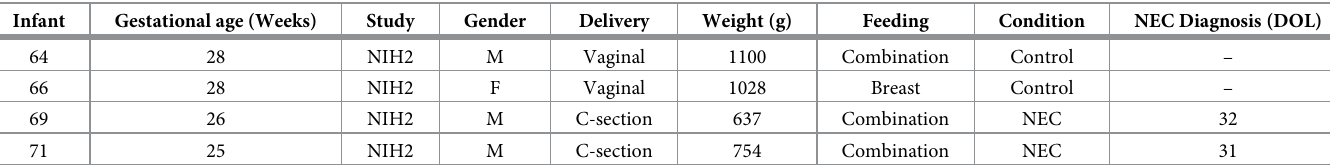
Table 1. Infant medical information.